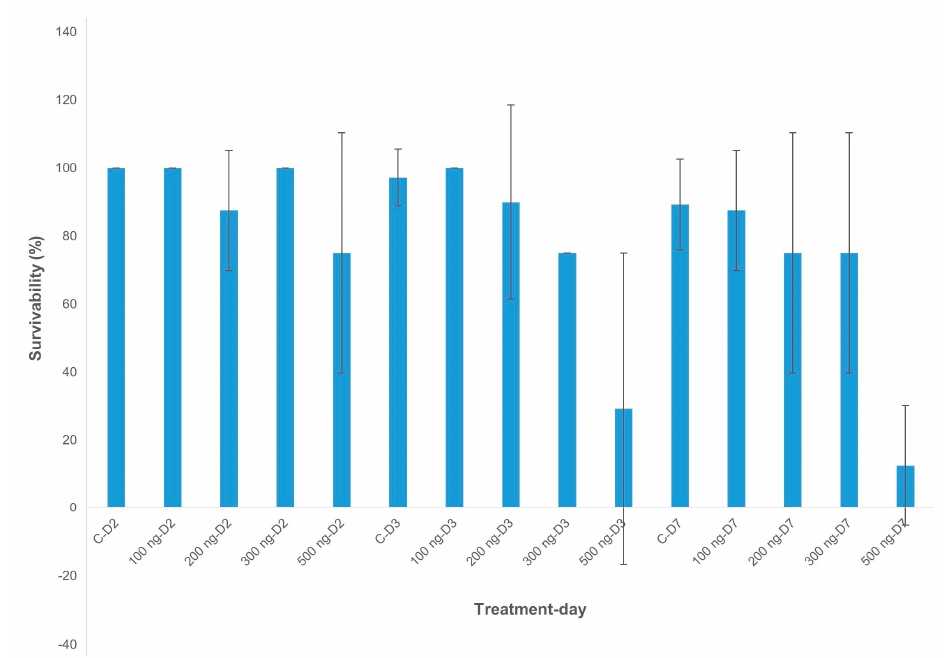
Figure 2. Banana aphid survivability curve at varying dsRNA concentrations and time intervals at day 2 (D2), day 3 (D3), and day 7 (D7). Data are presented as mean percentage survivability (%) and error lines indicate the standard deviation.